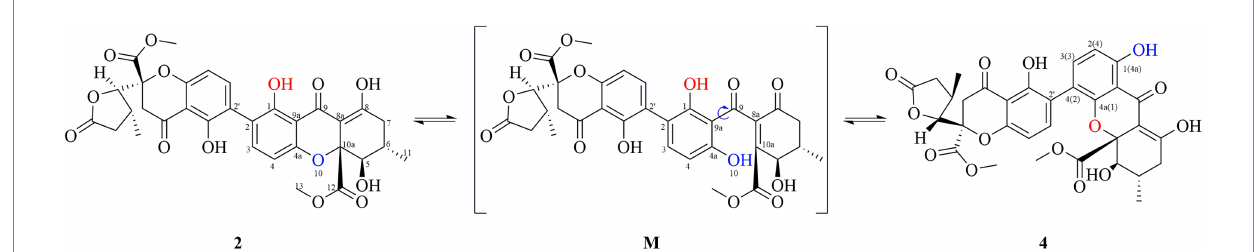
FIGURE 3 Proposed interconversion mechanism between 2 and 4 .